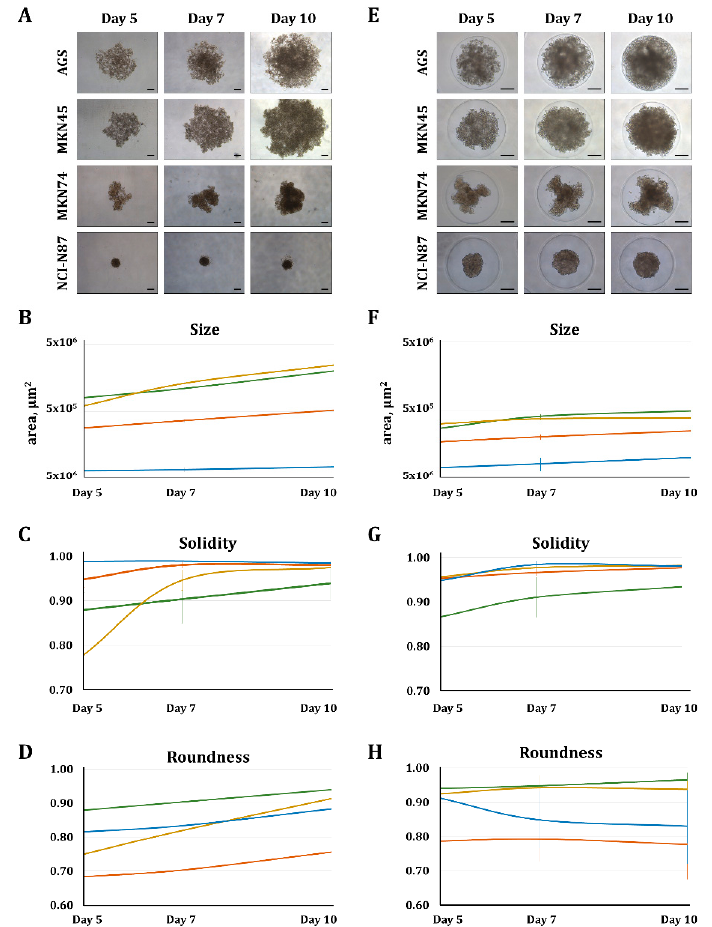
Figure 1. Comparison between two standardized methodologies (ULA and 3D Petri Dish ® ) for generation, imaging, and automatized analysis of gastric multicellular tumor spheroids (MCTS). ( A ) Representative images of gastric MCTS and the results of automated image analysis for ( B ) size, ( C ) solidity, and ( D ) roundness, generated using ULA 96-well round-bottomed plates. ( E ) Representative images of MCTS and the corresponding results of automated image analysis for ( F ) size, ( G ) solidity, and ( H ) roundness, generated with the 3D Petri Dish ® technology (MICROTISSUES ® ). Values are means ± SD of at least n = 3 (ULA) and n = 9 (3D Petri Dish ® ). For each condition, three independent experiments were performed. Scale bar represents 200 µm.